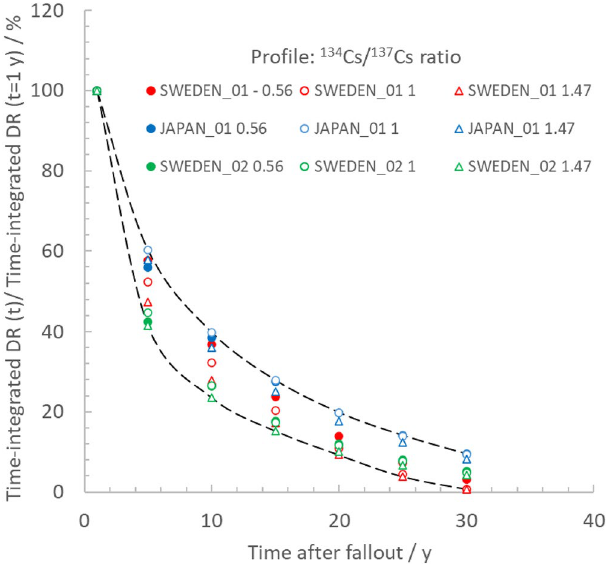
Figure 6. The action-influenced time-integrated dose reduction, TDR ( t cleanup ), in terms of averted effective dose by 5 cm soil removal, normalized to TDR ( t cleanup = 1 y) for the three different soil migration settings inTable 2 and three different 134 Cs/ 137 Cs initial isotope ratios at the time of